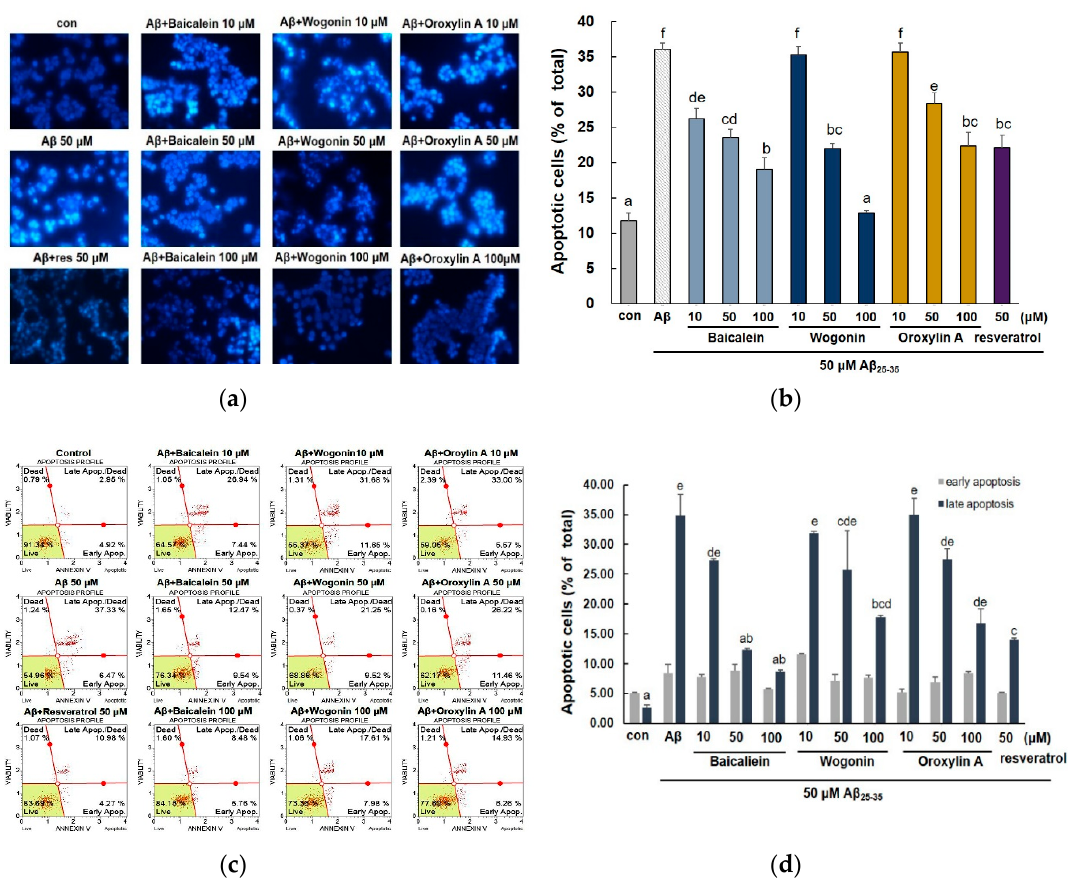
Figure 4. Effects of baicalein, wogonin, and oroxylin A on A β 25–35 -stimulated apoptosis in PC12 cells. The cells were pretreated with samples for 1 h, and stimulated with A β 25–35 for 24 h. Apoptotic cells were stained with Hoechst 33,342 ( a ). Quantification of apoptotic cells ( b ). Early and late apoptosis measured by flow cytometry ( c ). Statistical analysis results of the percentage of apoptosis by flow cytometry ( d ). Different alphabets indicated significant difference at p < 0.05.